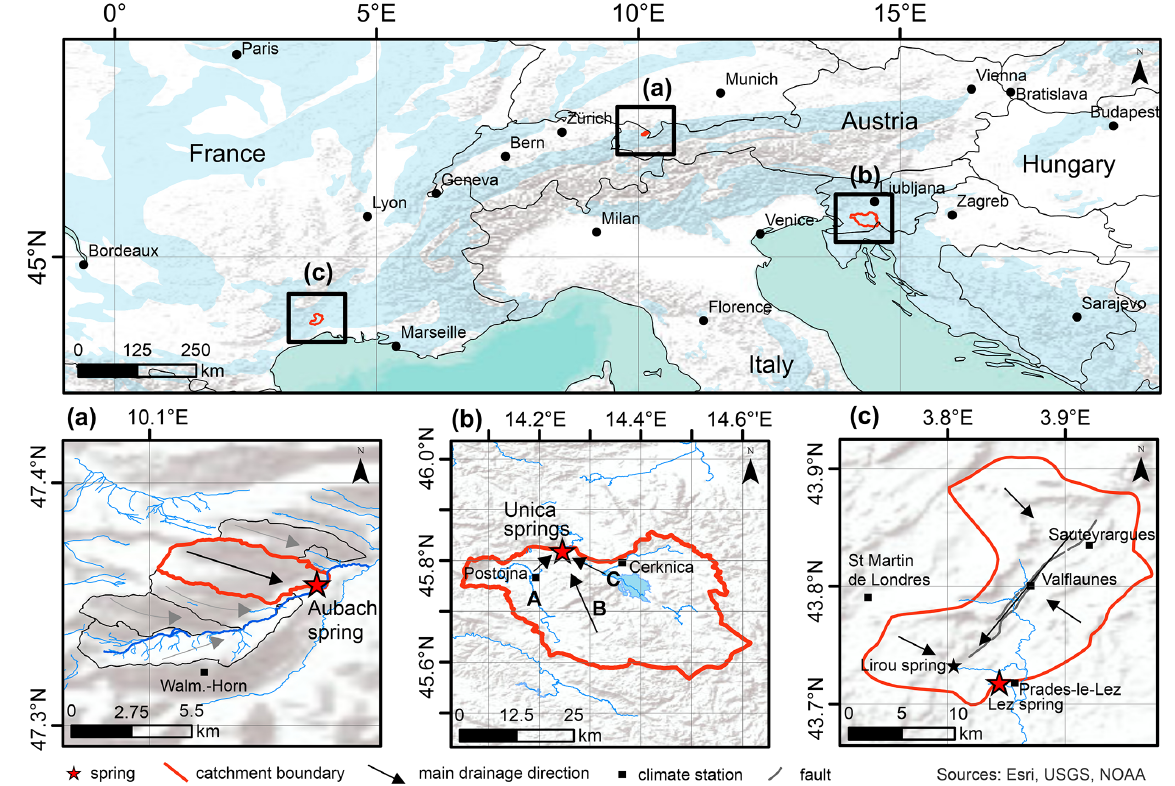
Figure 1. Overview of all three study areas, the simulated springs (red star), and their catchments (red lines). Black squares indicate the locations of climate stations used for 1D modeling (some are outside the shown maps), and blue shadings in the upper map show karst areas based on WOKAM (Chen et al., 2017a). (a) Hochifen-Gottesacker karst area and Aubach spring; black lines depict minor contributing subcatchments; (b) Unica River springs and Javorniki karst plateau (B); (c) Lez spring catchment, Lirou overflow spring (black star), and major fault Corconne-Les Matelles (grey